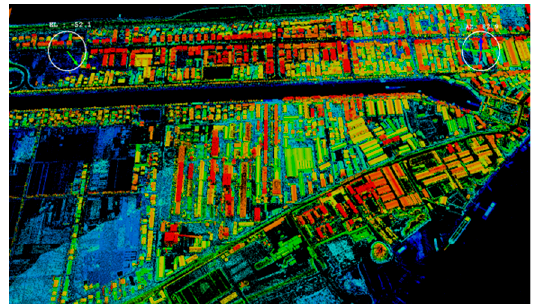
Figure 2. Example of airborne LiDAR point cloud.